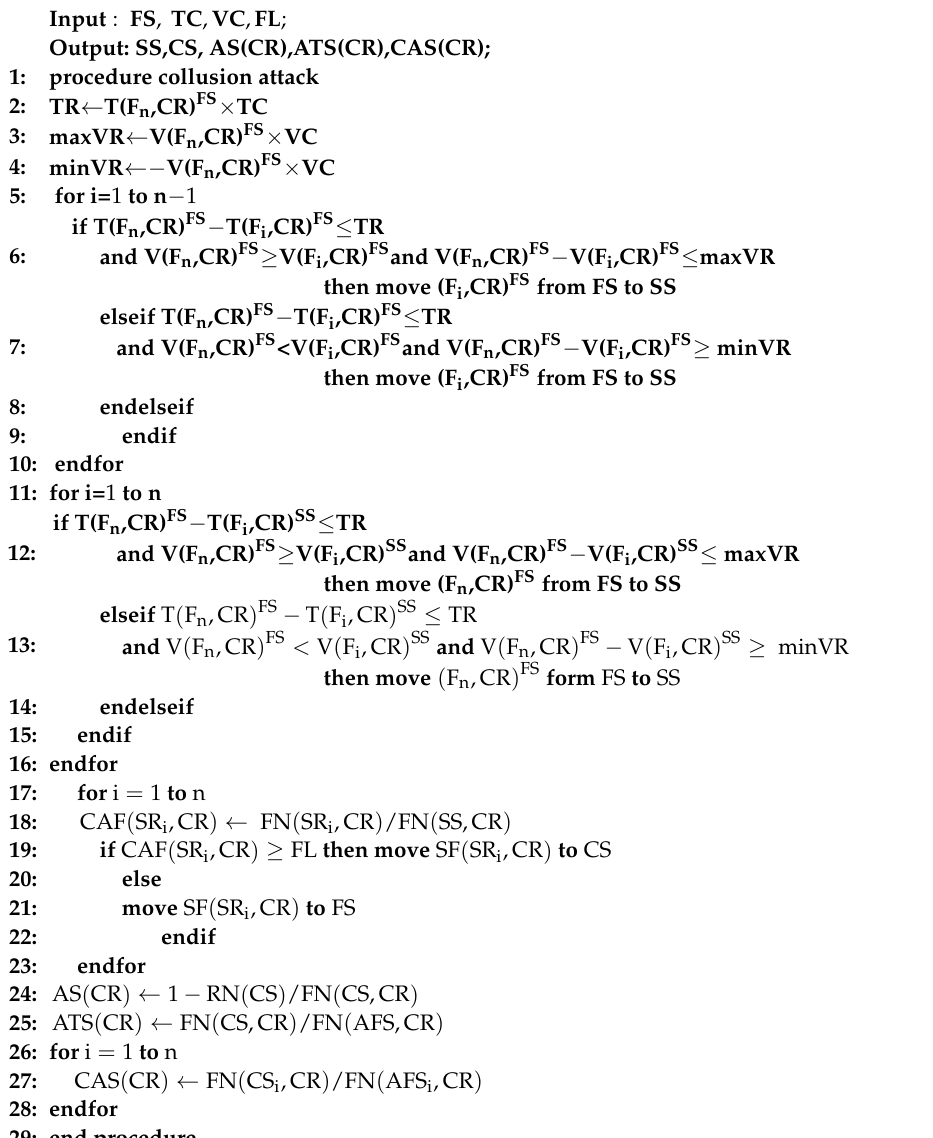
Algorithm 2 Collusion Attack